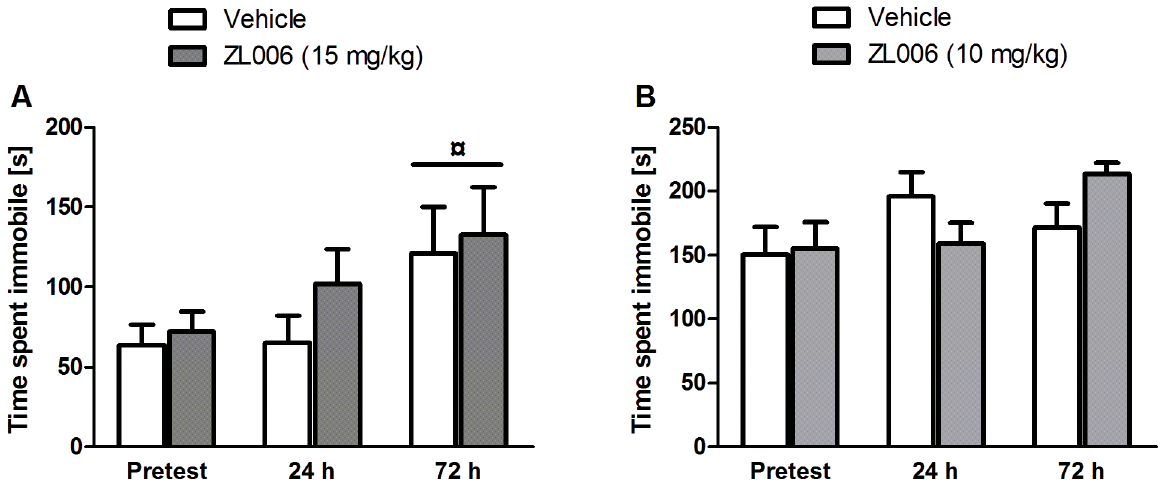
Fig 3. Sustained effects of ZL006 in Flinders Sensitive Line rats and B6NTac mice. A : Immobility of Flinders SensitiveLine rats in the Forced Swim Test at baseline(15 min pretest) and at 5-min test sessions 24 h and 72 h after injectionof vehicleor ZL006 (15 mg/ kg). Rats were more immobile72 h after injections; ¤ : p (cid:20) .05 comparedwith the pretest; n = 7/group. B : Immobilityof B6NTac mice in 6-min Tail Suspension Test sessions at baseline(pretest) and 24 h and 72 h after injectionof vehicleor ZL006 (10 mg/kg); n = 11–13/ group. Values are expressedas means ± SEM and were analyzedusing a three-way mixed ANOVA (A) and one-wayANOVA (B) followedby